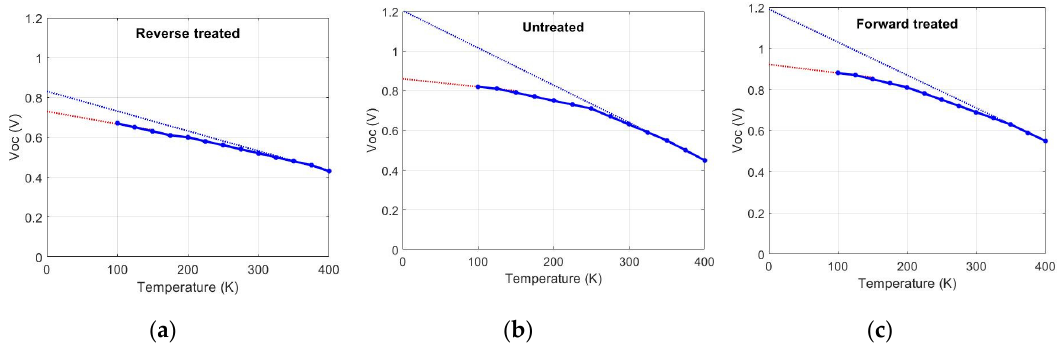
Figure 4. Voc against temperature plots for ( a ) the reverse bias-treated sample, ( b ) the untreated sample and ( c ) the forward bias-treated sample with the highest illumination level (100% transparency). For each curve, a trendline is included in both the low- (red) and high- (blue) temperature regime to extrapolate the value of Voc to 0 K.